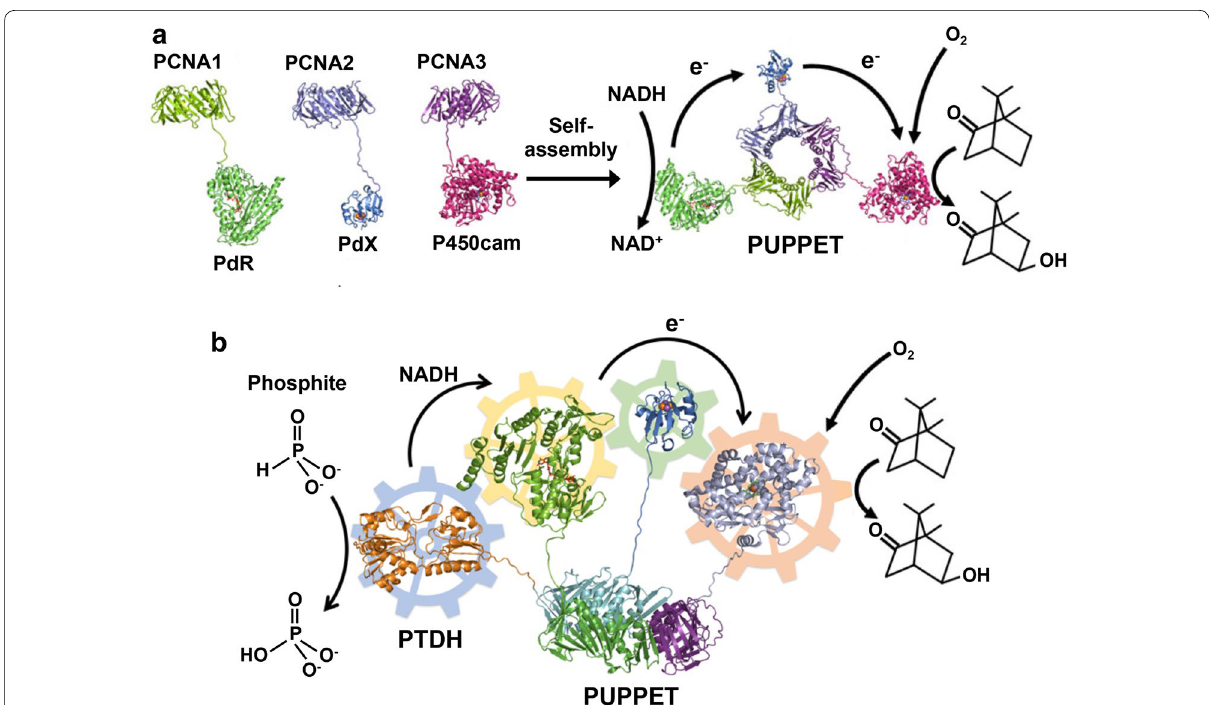
Fig. 12 Schematic illustration of PCNA-mediated multienzyme complex formation. a Self-assembly of PCNA-based heterotrimeric complex (PUPPET) consisting of P450cam, its electron transfer-related proteins PdR and PdX that catalyzes the hydroxylation of d -camphor. b PTDH-PUPPET complex that catalyzes the hydroxylation of d -camphor by regenerating NADH with consumption of phosphite ( a reproduced with permission from: Ref. [111]. Copyright (2010) Wiley–VCH. b Reproduced with permission from: Ref. [115]. Copyright (2013)